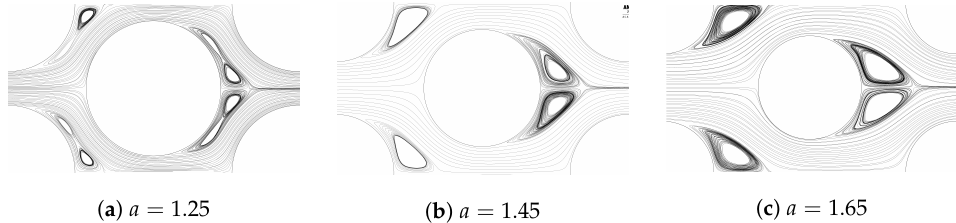
Figure 10. Velocity streamlines for the central rod of the fifth column of the staggered bundle at Re = 6.11 × 10 4